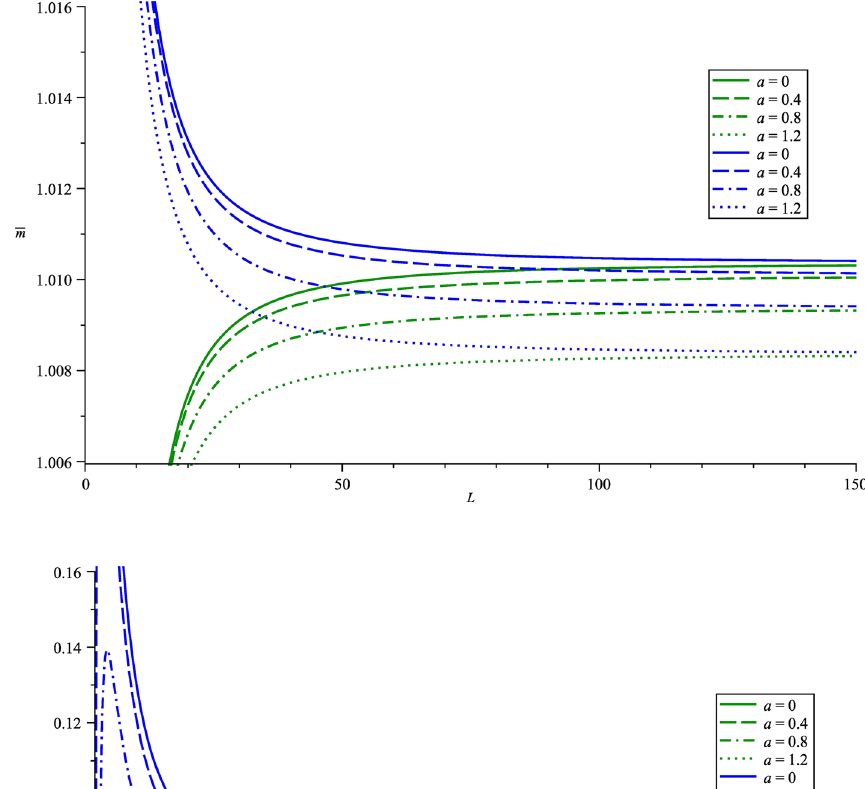
Fig. 7 Unruh temperature T U and effective temperature T eff in AdS (blue) and dS (green) with parameters Q 2 + P 2 = 12 , qQ + pP = 6 , m = 1 ,λ l = 0 , n =